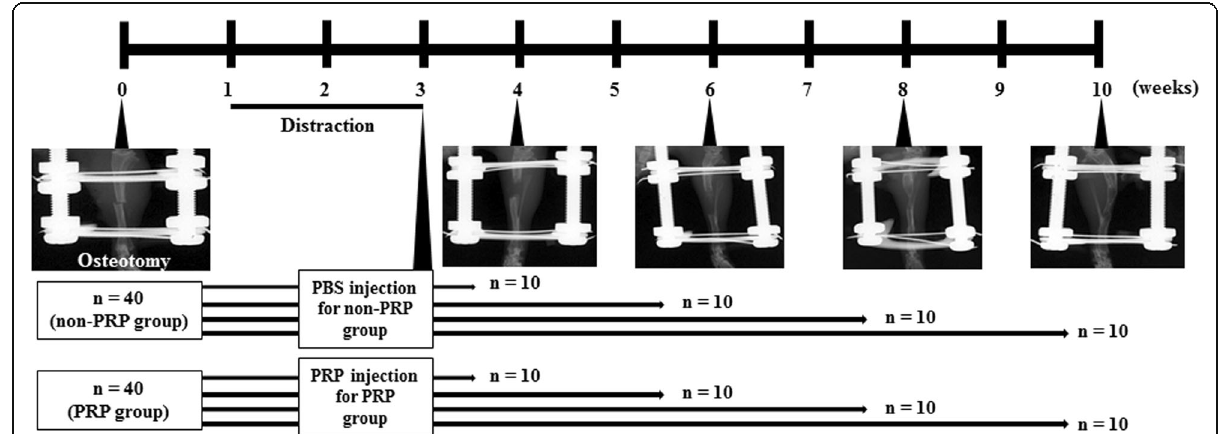
Fig. 1 Experimental protocol and representative radiographs of distraction osteogenesis from 0 to 10 weeks after